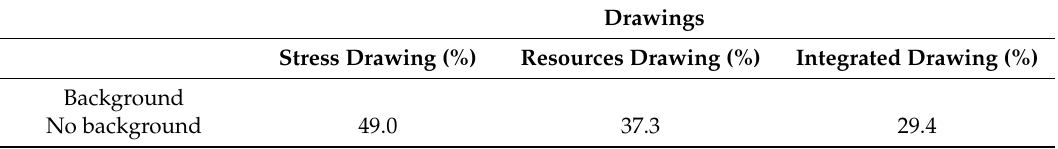
Table 3. Descriptive statistics of the compositional characteristics of the three drawings ( N =